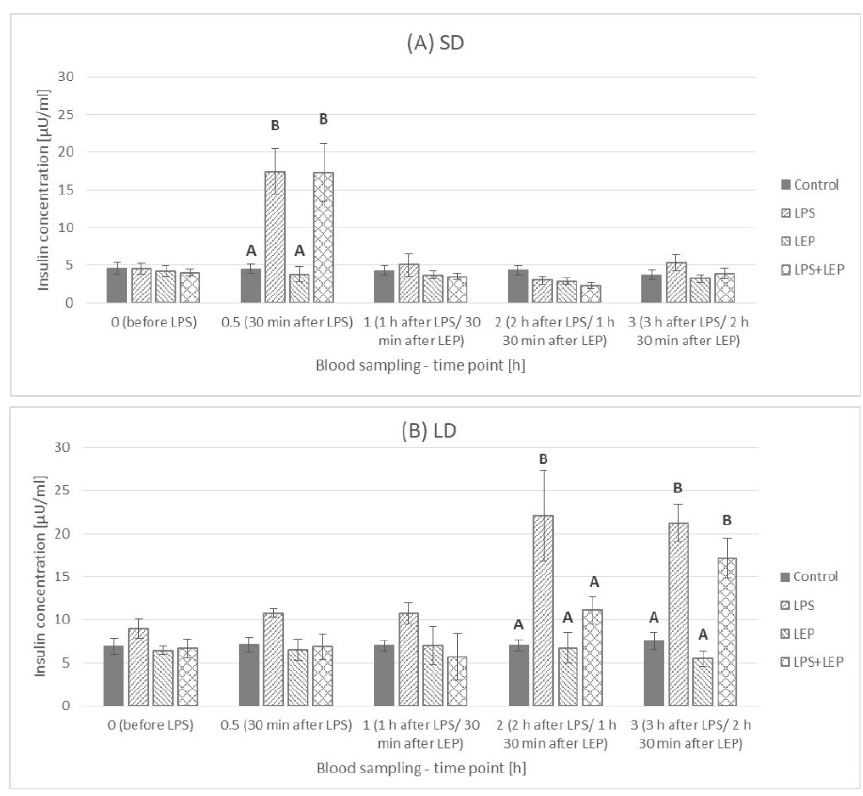
Figure 9. Plasma insulin concentration—comparison among the experimental groups (Control, LPS, LEP and LPS + LEP) for the short-day (SD) ( A ) and long-day (LD) ( B ) photoperiods for each selected time point separately; A,B—bars with different letters differ significantly within each time point according to the two-way analysis of variance (ANOVA) followed by Fisher’s post-hoc test ( p ≤ 0.05) ( n = 6). Groups: control—saline injection, LPS—lipopolysaccharide injection at a dose of 400 ng/kg of body mass at a 0 h time point, LEP—leptin injected at a dose of 20 μ g/kg of body mass at a 0.5 h time point, LPS + LEP—LPS and LEP injections at the same doses and time points as those in the LPS or LEP group.